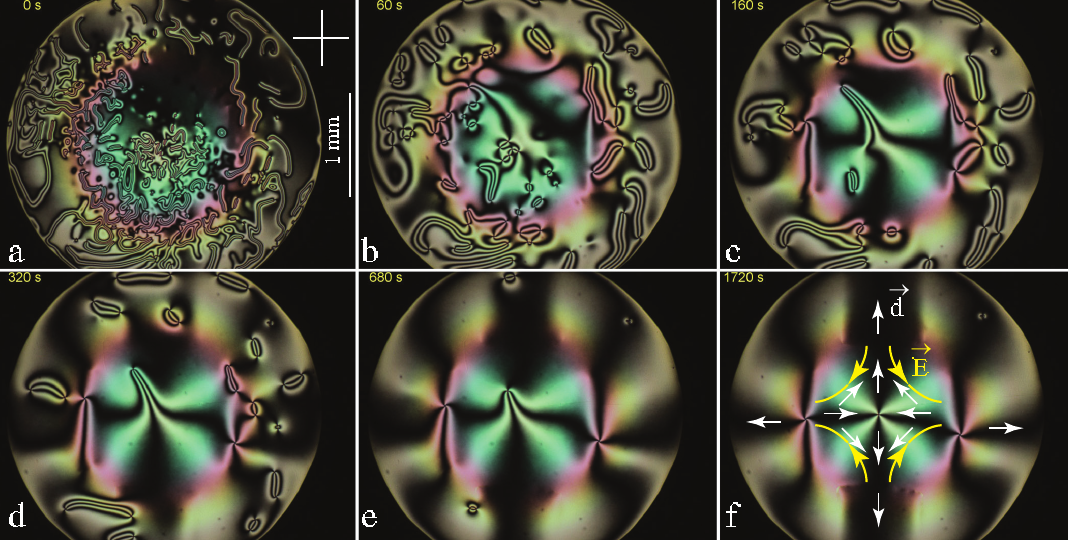
Figure 16. Triplet of dowsons stabilised by a quadrupolar electric field. ( a ) Initial configuration. ( a – f ) Relaxation through annihilation of dowsons pairs. ( f ) Final triplet configuration stabilised by the electric field. In MBBA, the dowser field is antiparallel to the electric